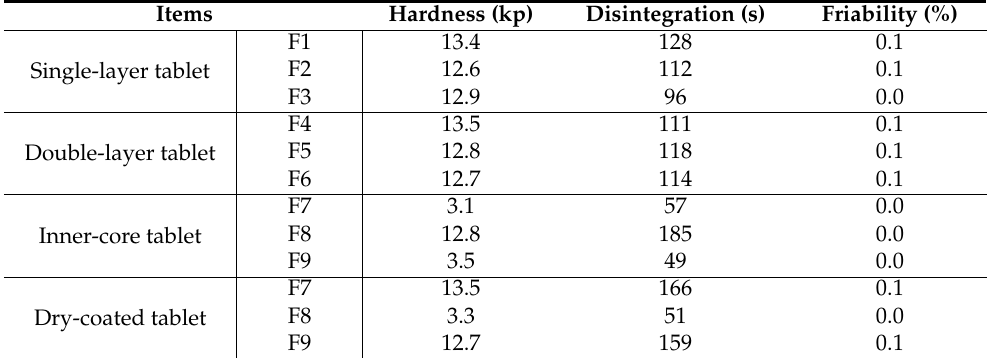
Table 11. Quality assessment of sitagliptin phosphate monohydrate-dapagliflozin propanediol hydrate FDC tablets.